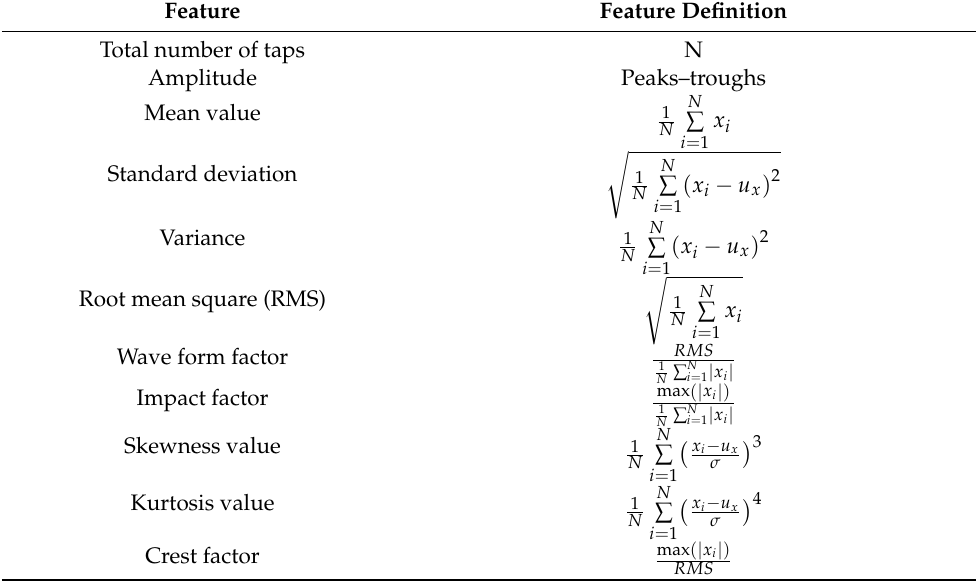
Table 1. Statistical features of